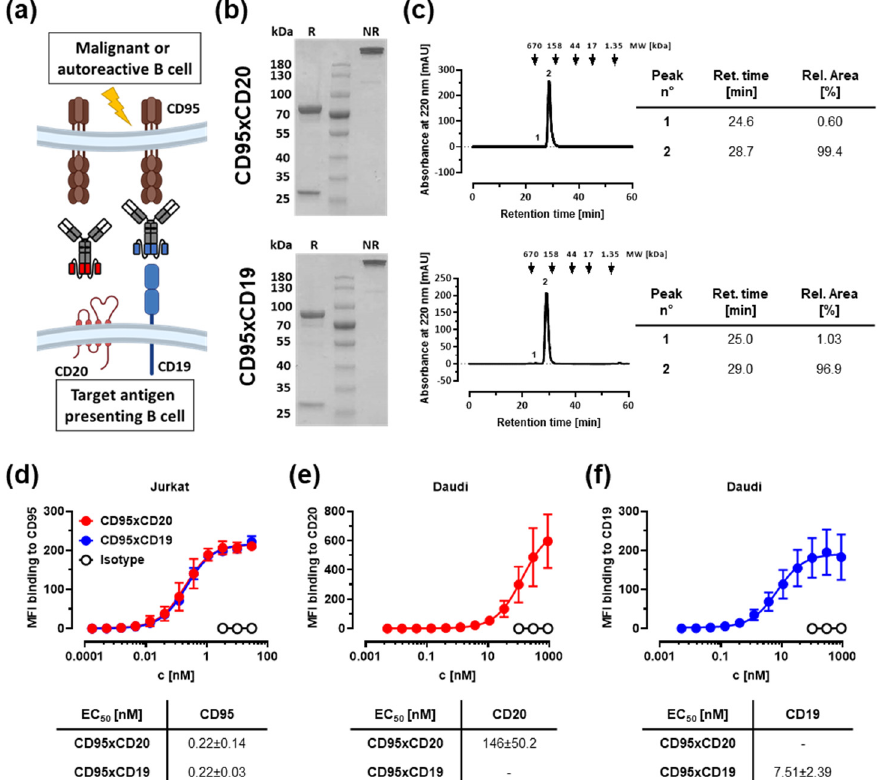
Figure 1. Characterization of improved anti-CD95 bsAbs targeting CD20 or CD19. ( a ) Schematic representation of how the bsAbs induce a target-mediated clustering of the Fas receptor and ultimately lead to apoptosis of the target cell. Created with BioRender.com (accessed on 18 May 2022). ( b ) SDS-PAGE of the bispecific CD95xCD20 (top) and CD95xCD19 (bottom) molecules. R: reduced; NR: non-reduced. ( c ) Both antibodies were subjected to analytical size exclusion chromatography (SEC). The corresponding analysis is presented in the tables on the right. ( d – f ) Binding to CD95-expressing Jurkats ( d ) and Daudi cells expressing CD20 ( e ) and CD19 ( f ) was assessed by flow cytometry. Mean ± SD, n = 3.